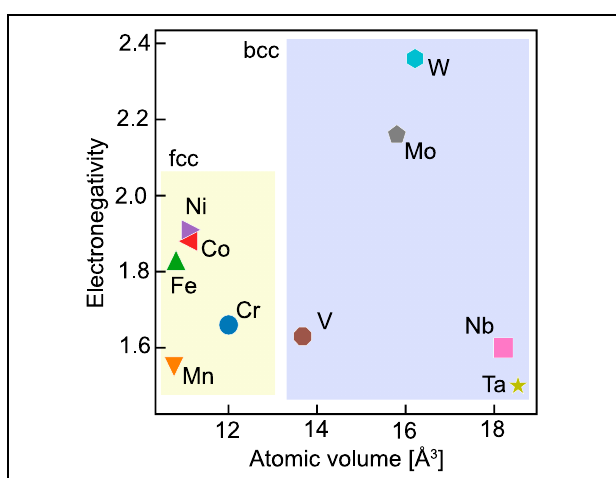
FIGURE 1 | Electronegativity versus atomic volume for the constituent elements in the case of a pure bulk